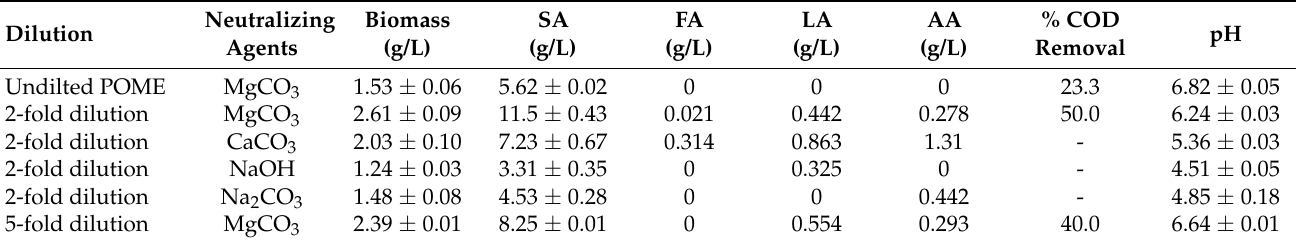
Table 2. Succinic acid and biomass productions from POME at the various dilution and neutralize agents (15 g/L) by E. gallinarum at the cultivation period of 60